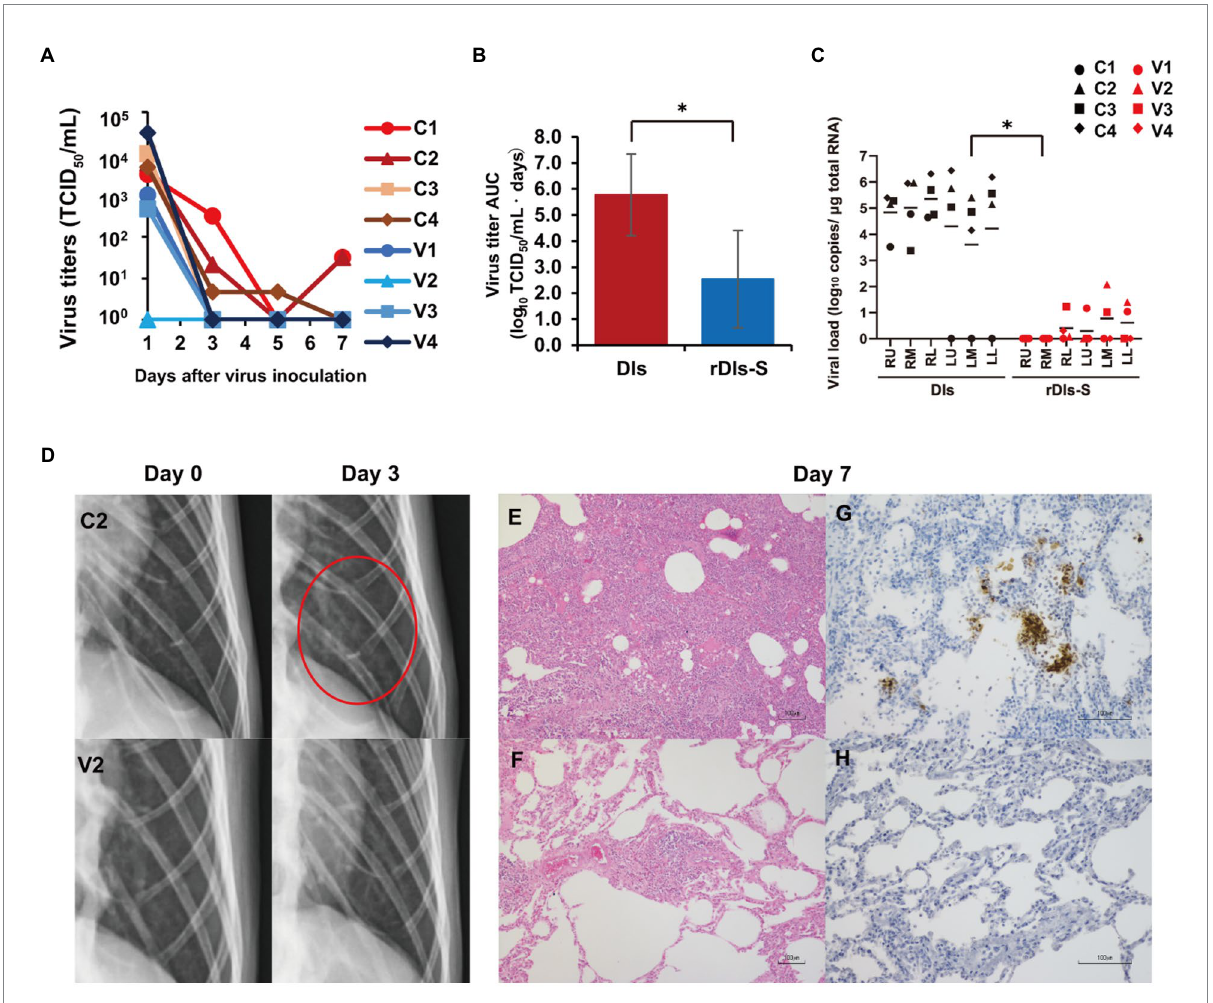
FIGURE 3 Protection from SARS-CoV-2 pneumonia in macaques vaccinated with rDIs-S. Cynomolgus macaques were immunized intradermally with DIs (C1–C4) or rDIs-S (V1–V4). One week after the second vaccination, SARS-CoV-2 strain WK-521 was inoculated into the conjunctiva, nostril, oral cavity, and trachea of each macaque at Day 0. (A) Nasal swab samples were collected on the indicated days after virus inoculation. Viral titers below the limit of detection (LOD; 0.67 log 10 TCID 50 /ml) are shown as 10 0 . (B) Means and standard deviations of virus titer areas under the virus titer time curve (virus titer AUCs) in nasal swab samples were calculated based on the titers shown in (A) and Supplementary Table 1. Virus titers under the detection limit were treated as 0 in the calculations. Means and standard deviations across each quartet of macaques are shown. Red: DIs; blue: rDIs-S. Value of p was calculated using a two-tailed Student’s t -test (* p = 0.039). (C) Lung tissues were collected 7 days after virus inoculation. Viral RNA was quantified by qRT-PCR. RU, right upper lobe; RM, right middle lobe; RL, right lower lobe; LU, left upper lobe; LM, left middle lobe; and LL, left lower lobe. Viral loads of all lung lobes were compared between DIs and rDIs-S using a two-tailed Student’s t -test (* p = 0.012). (D) X-ray radiography was performed at Day 0 before infection and at Day 3 after infection. Representative photos are shown. The red circle indicates the ground glass appearance. (E,F) Hematoxylin- and eosin-stained sections of lung. (G,H) Immunohistochemical staining of lung sections for SARS- CoV-2 N antigen (brown color). Nuclei were stained with hematoxylin. Bars indicate 100 μ m in E – H . (E,G) C2: a macaque immunized with DIs. (F,H) V2: a macaque immunized with rDIs-S. Bars indicate 100 μ